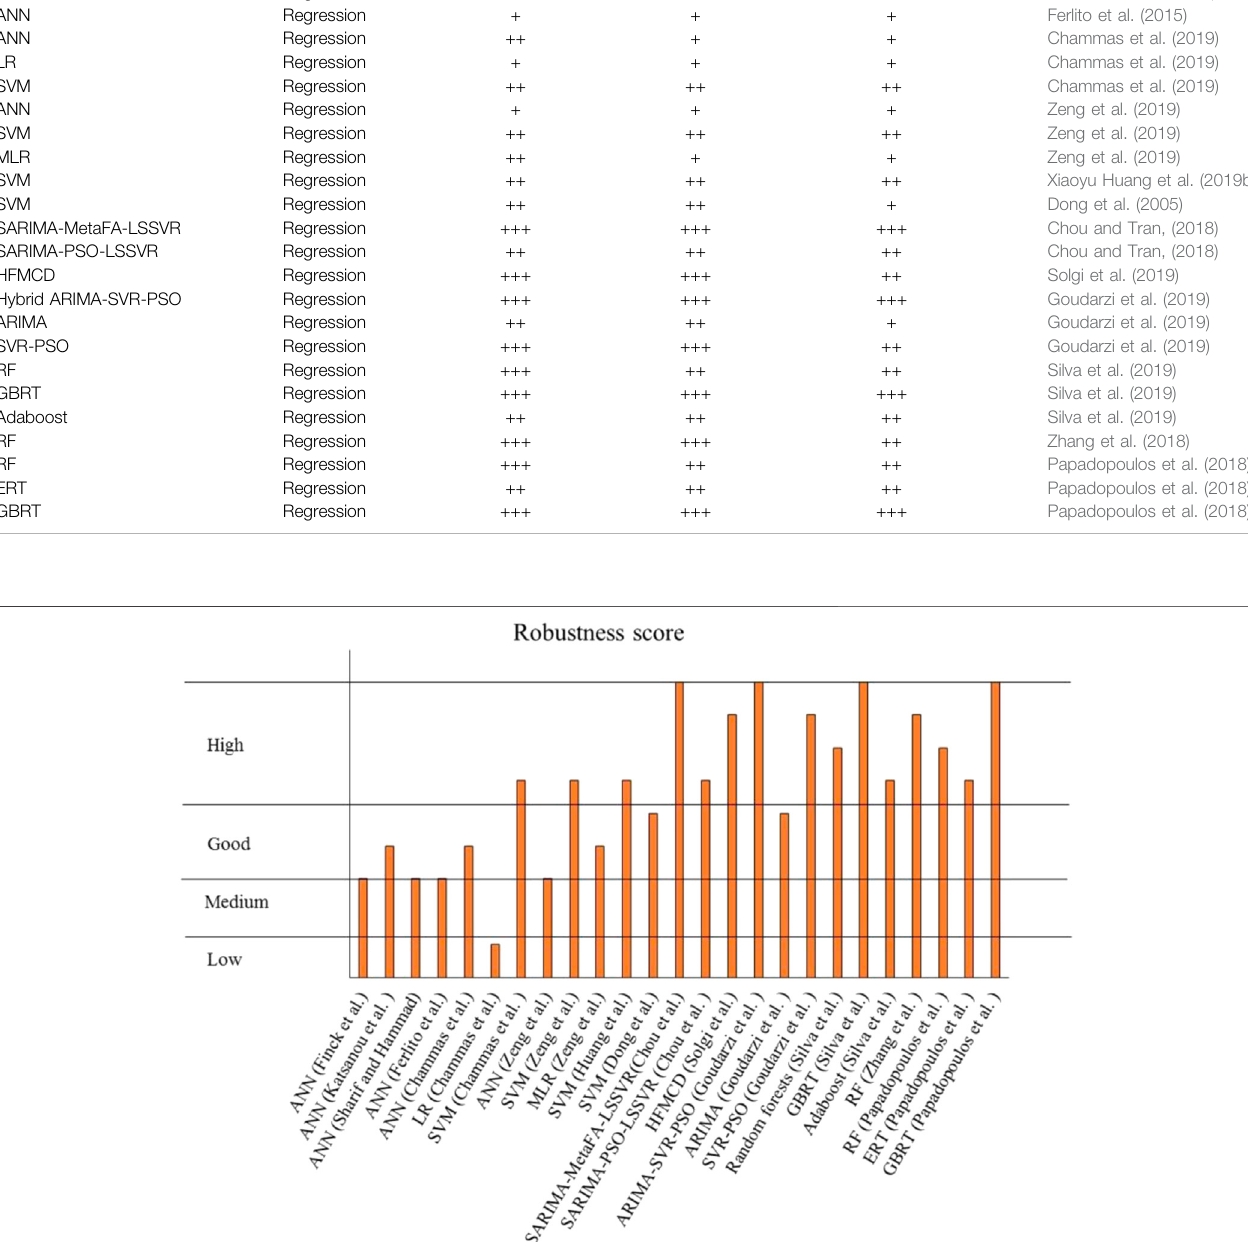
Frontiers in Energy Research |